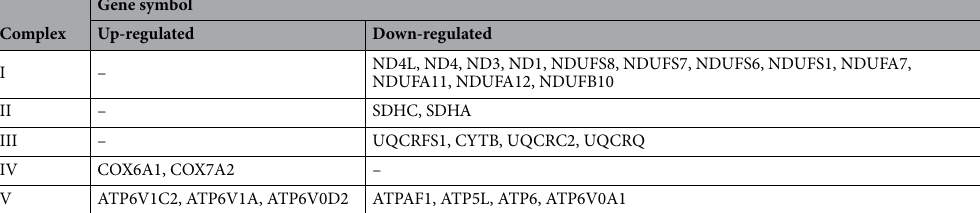
Table 3. Differentially expressed genes involved in oxidative phosphorylation.